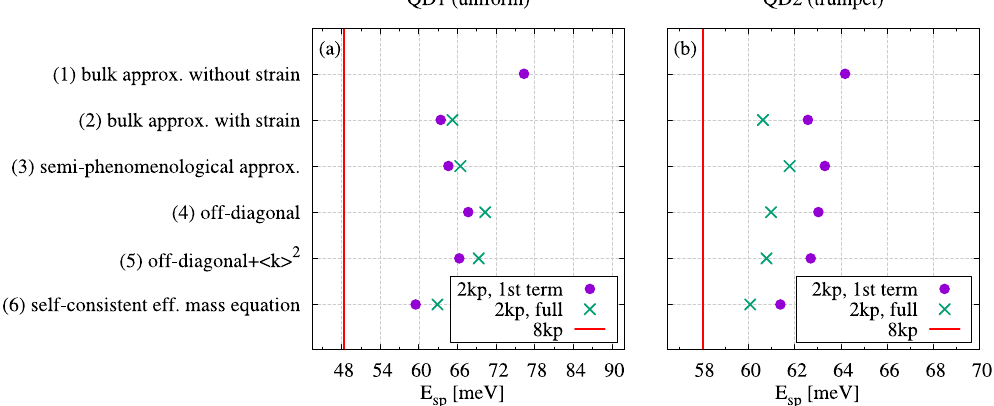
Figure 1. Energy splitting between the ground and first excited states at zero magnetic field for the sequence of approximations. Dots show the results obtained using only the first term in Eq. (12), while crosses represent the results from the full Hamiltonian. The red line shows the value obtained from the 8-band k · p calculation.